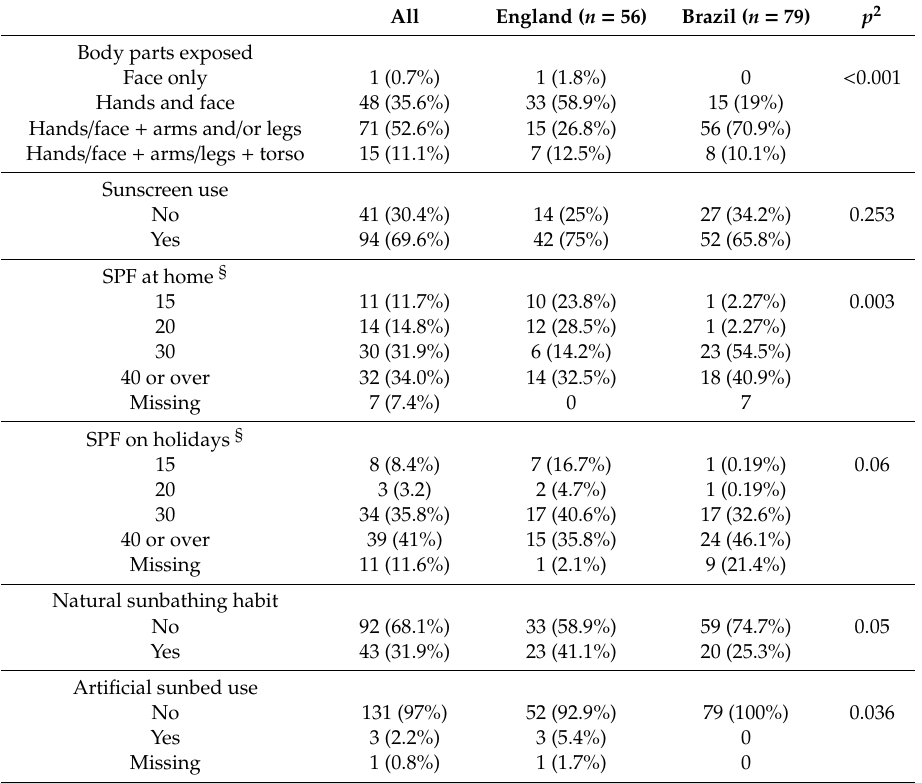
Table 3. Sun-exposure behaviours of adult Brazilian women overall and by country of residence ( n = 135) 1 . All England ( n = 56) Brazil ( n = 79) p